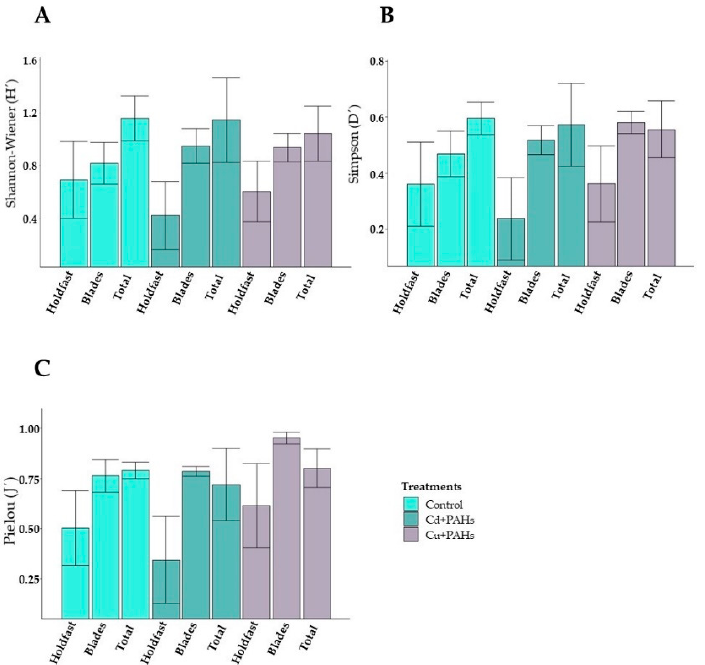
Figure 4. Community index determined in the holdfast, the blades, and the total (complete) thallus of Macrocystis pyrifera subject to different treatments (control, Cd + PAHs, and Cu + PAHs). Shannon–Wiener ( A ), Simpson ( B ), and Pielou ( C ) indexes. n = 5 ± standard error.